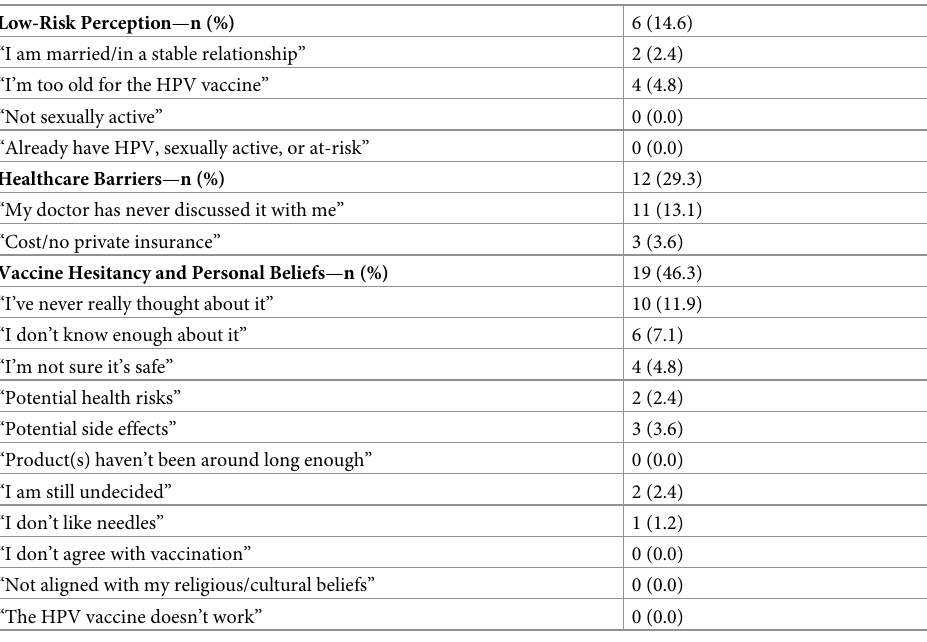
Table 3. Barriers to HPV vaccination in unvaccinated participants (N = 41).